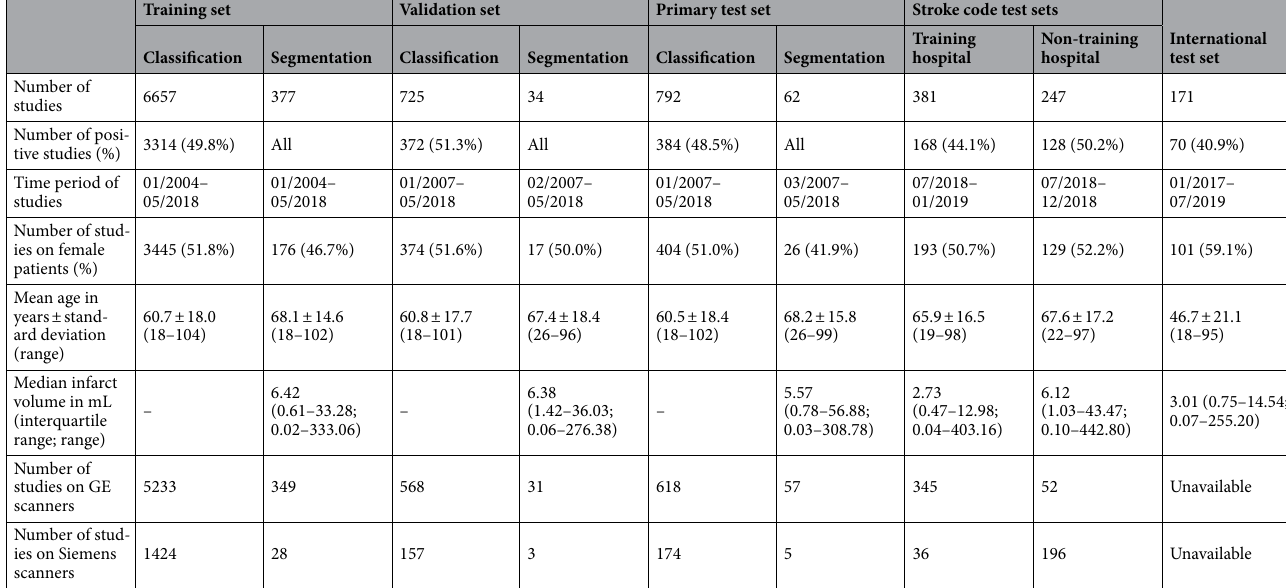
Table 1. Dataset details: the properties of the datasets that were used for model training and